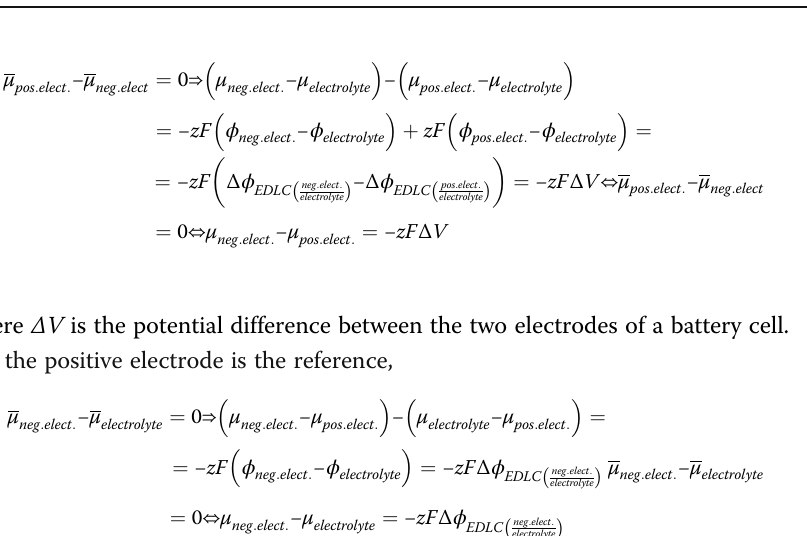
Fig. 1 Schematics of the chemical potentials in a closed system battery cell when the electrolyte chemical potential is the